Question: Looking at the figure, what chart type is it?
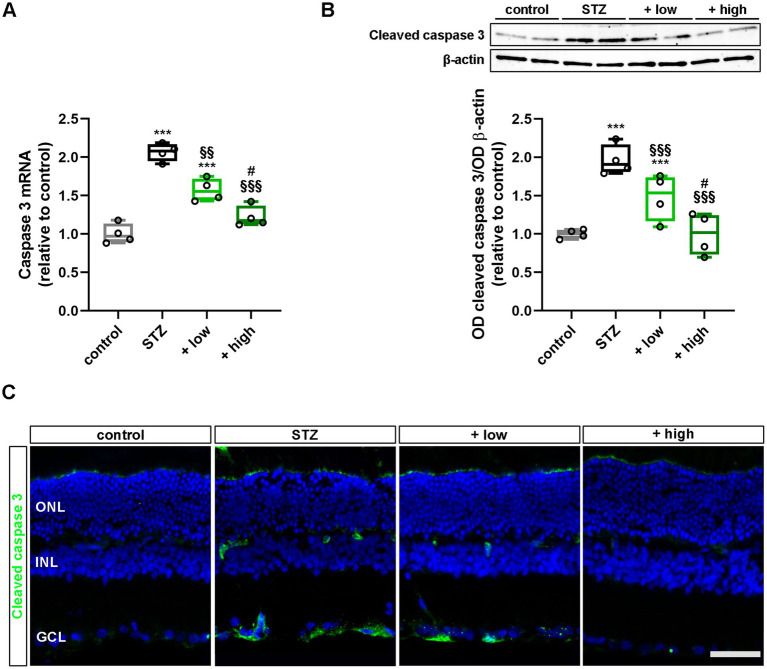
Answer: box